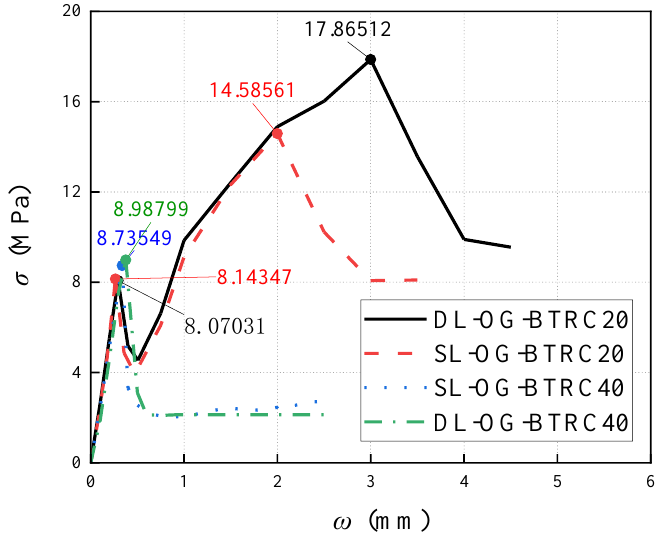
Figure 5. Bending stress–midspan deflection curve of BTRC plates with different laying methods.